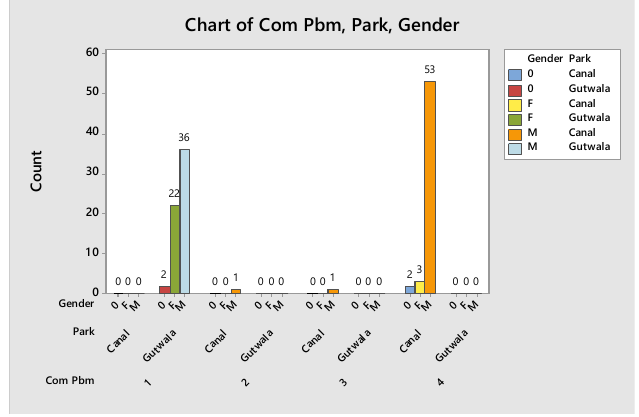
Figure 15: Bar Chart of Communication problem between both sites Graphical representation in fig. 14 represents 53 male and 3 female out of 60 visitors responded highly affected by the communication problem due to noise pollution while 1 female out 60 showed mild and 1out of 60 showed low response and 2 did not show any response in the site-1 Canal Park, contrarily, all sampled 60 visitors including both male and female except 2 visitors in the Site-2 Gat Wala Park did not show any symptom of communication problem due to noise pollution.